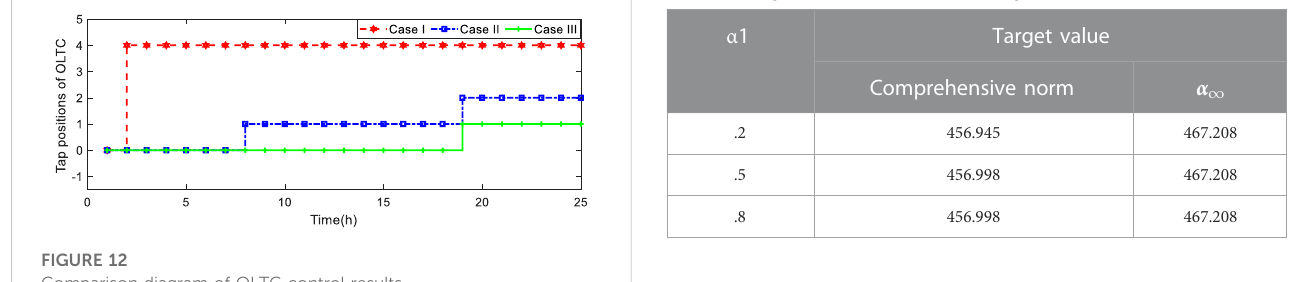
TABLE 6 Comparison of result between comprehensive norm and norm-inf.